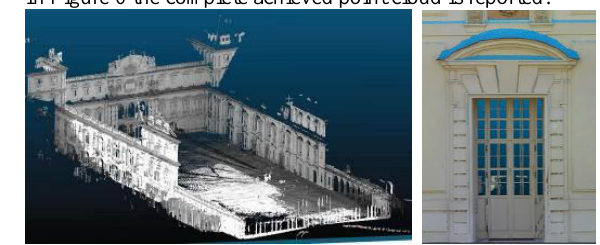
Figure 6 General view of the realized TLS survey (left), zoom on the acquired windows (right).